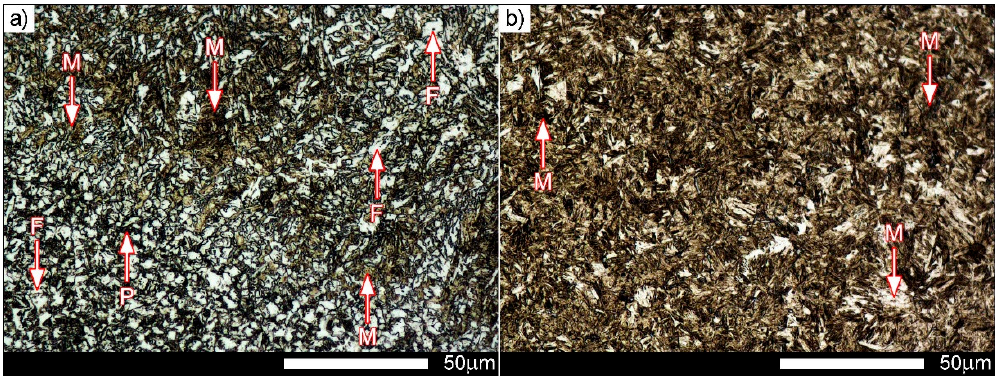
Figure 14. Magnified images of microstructures shown in Figure 13 (fusion zone FZ2): ( a ) after welding; and ( b ) after welding and heat treatment. B—bainite, F—ferrite, M—martensite, P—pearlite. Light microscopy, etched with 2% HNO 3 .